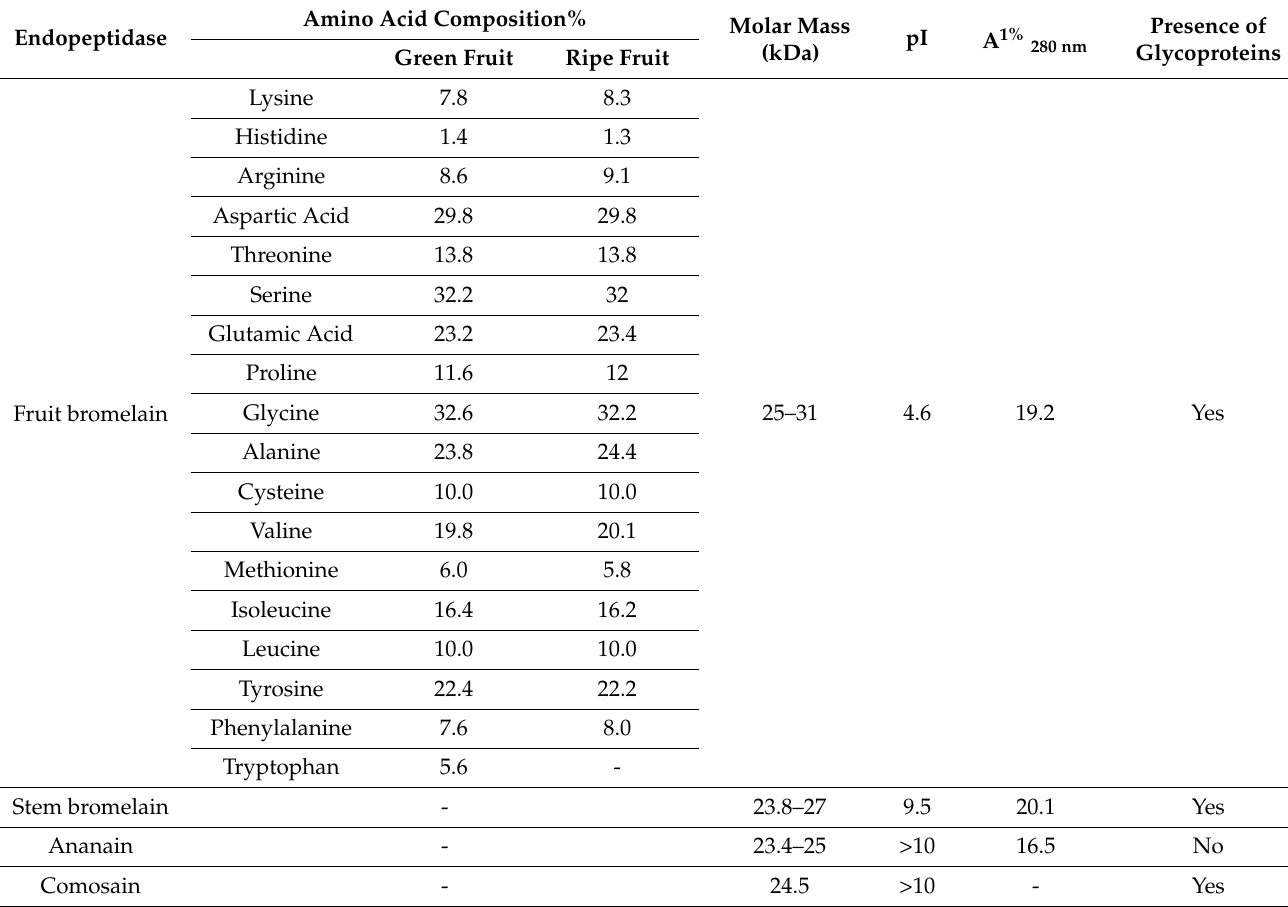
Table 1. Physicochemical characteristics of pineapple endopeptidases and amino acid composition of both green and ripe fruits (adapted from Rowan and Buttle [15] and Murachi